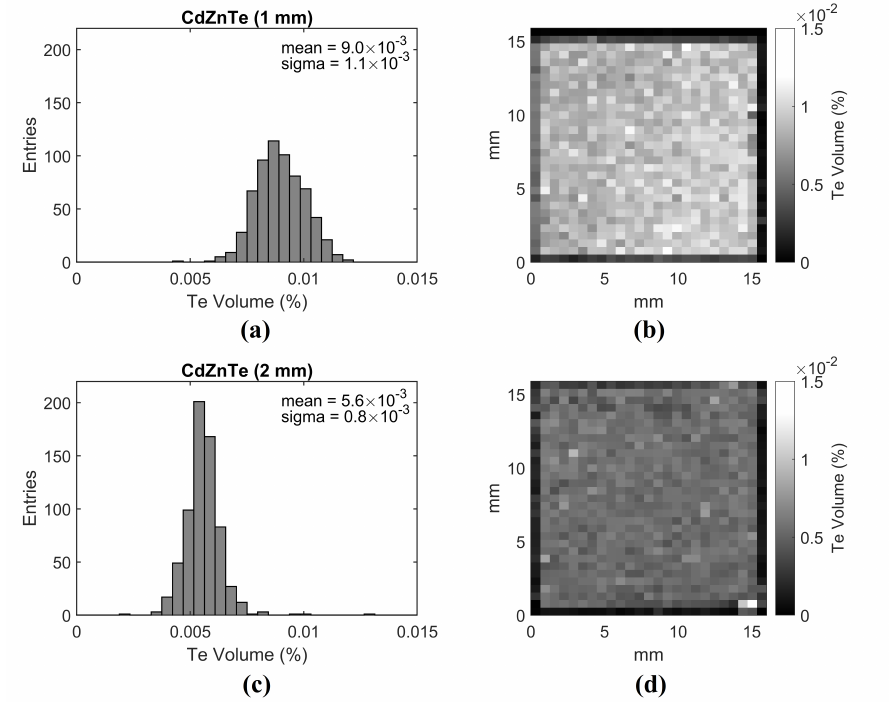
Figure 3. Histograms of the percent fraction occupied by Te inclusions in each voxel of the crystal volume, for the 1 mm ( a ) and 2 mm-thick ( c ) detectors, respectively. Corresponding x-y map of the crystal showing the uniformity for the 1 mm-thick ( b ) and 2 mm-thick ( d ) detectors. The maps are affected by edge effects because the external rows of voxels are only partially filled by the crystal volume; these external voxels have been excluded from the histograms ( a , c ) to avoid